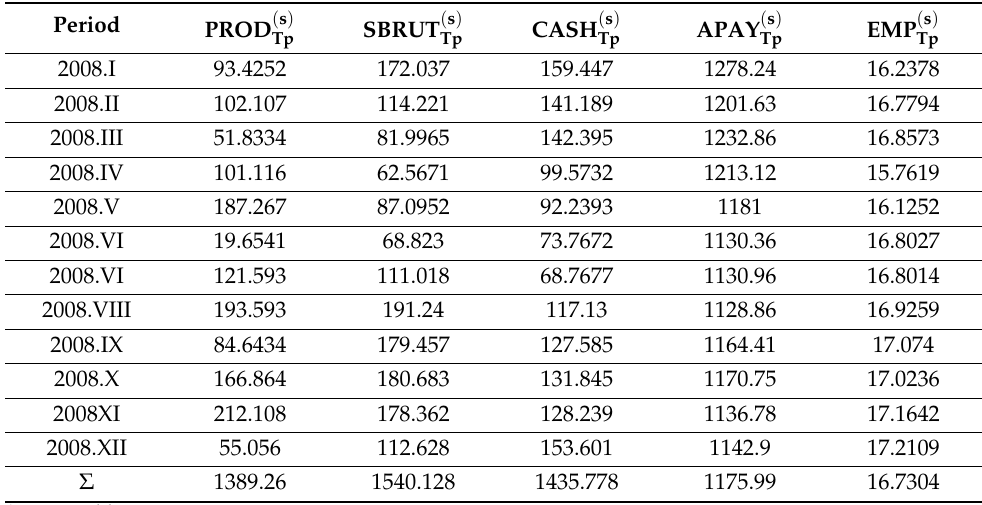
Table 5. Comparison of the variable forecasts forming the cycle in a 2008 annual system, without a change and after increasing the value of an exogenous variable (MACH). Annual Sum of the Forecasts * Annual Sum of the Forecasts * Variable of Individual Variables without a Change of Individual Variables after Increase in in the Value of MACH the Value of MACH